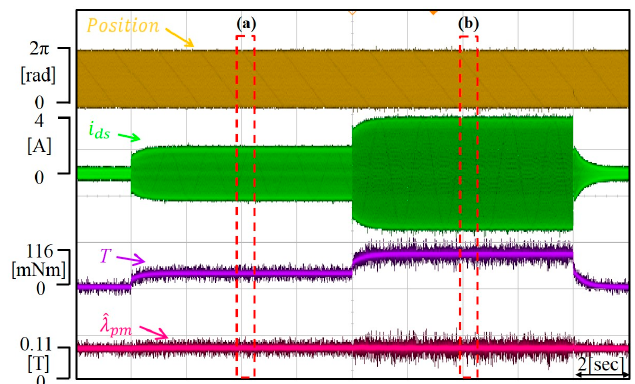
Figure 15. Characteristics of a SPMSM drive without applying the proposed algorithm. (Operating condition: ω r = 620 rad/s, PM temperature = 100 °C).